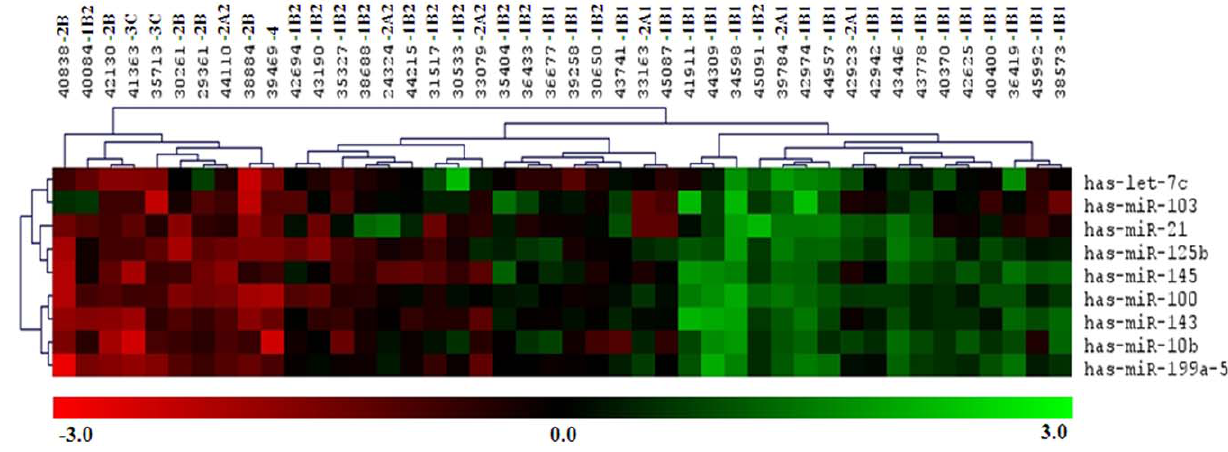
Figure 3. Unsupervised hierarchical cluster analysis of nine differentially expressed miRNAs in 44 samples of advanced and early stage small cell carcinoma of the cervix. Each row represents an individual miRNA and each column represents an individual tissue sample. Two major cluster branches were created, one including mainly advanced tumor stage samples and the other including mainly early tumor stage samples. Red, black, and green pseudocolors indicate transcripts levels below, equal, or above the mean, respectively, on a scale representing gene expression ratios from 2 3 to 3 on a log 2 scale.